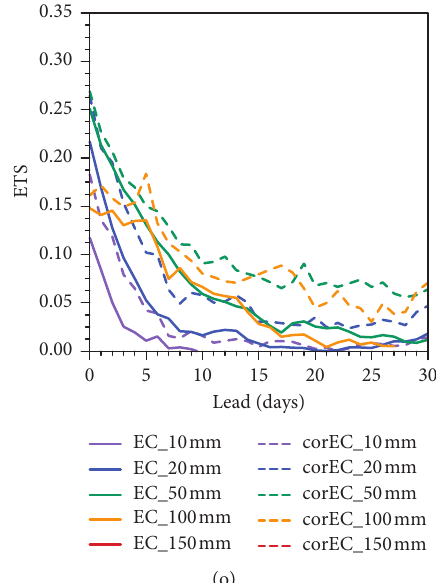
Figure 11: The FAR, POD, and ETS in (a, f, and k). Reg1; (b, g, and l). Reg2; (c, h, and m). Reg3; (d, i, and n). Reg4; (e, j, and o). Reg5 of eastern China from error-uncorrected and error-corrected ECMWF S2S hindcast experiment for rainy events exceeding 10, 20, 50, 100, and 150mm over ten days at the lead times of 0–30 days, and the period is 1995–2014. Purple, blue, green, orange, and red lines represent the results of error- uncorrected ECMWF hindcast for rainy events exceeding 10, 20, 50, 100, and 150mm over ten days. Purple, blue, green, orange, and red dashed lines indicate the results of error-corrected ECMWF hindcast for rainy events exceeding 10, 20, 50, 100, and 150mm over ten